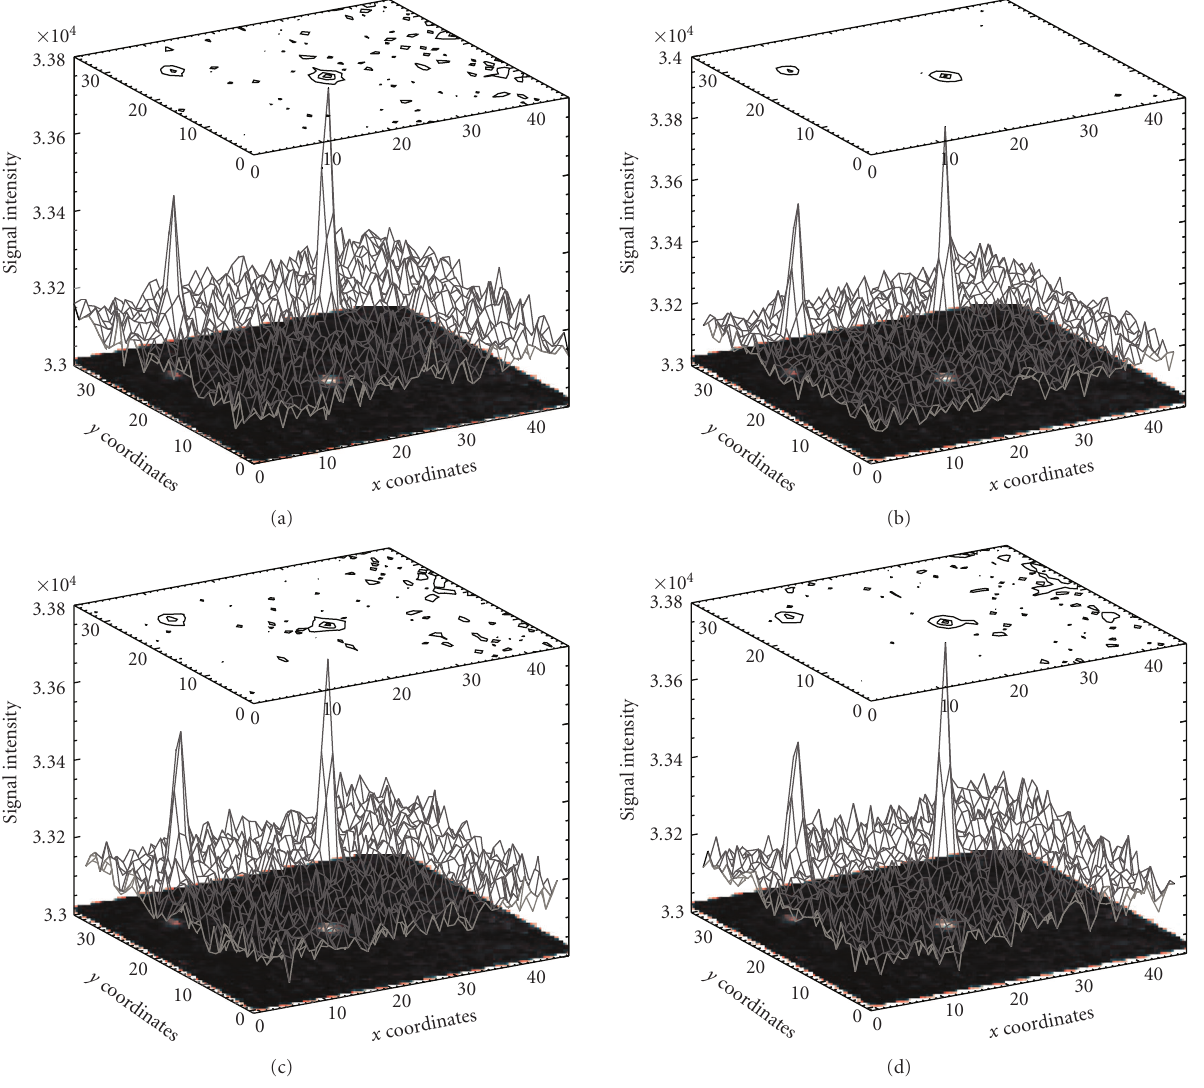
Figure 4: An example of observations acquired with continuous exposures time of 0.13 seconds per frame, under relative extreme sky conditions. The plots combine an image (image size: 2 . 5 ◦ × 2 . 5 ◦ ), a surface plot of the image data, and a contour plot of the images data in a single tri-level display. The x -axis and y -axis indicate the pixel coordinates place in the center of the image frame at the position: RA(J2000) = 14h : 31 m : 40.7 s, DEC(J2000) = 36d : 18 (cid:2) : 14.7 (cid:2)(cid:2) and the z -axis represents the signal intensity. The values of the a ff ective air mass and the seeing are estimated to be ∼ 2.61 and ∼ 0.9 (cid:2)(cid:2) , respectively. At the corresponding time the percent of the Moon illuminated is 98% at a distance of 58 ◦ from the